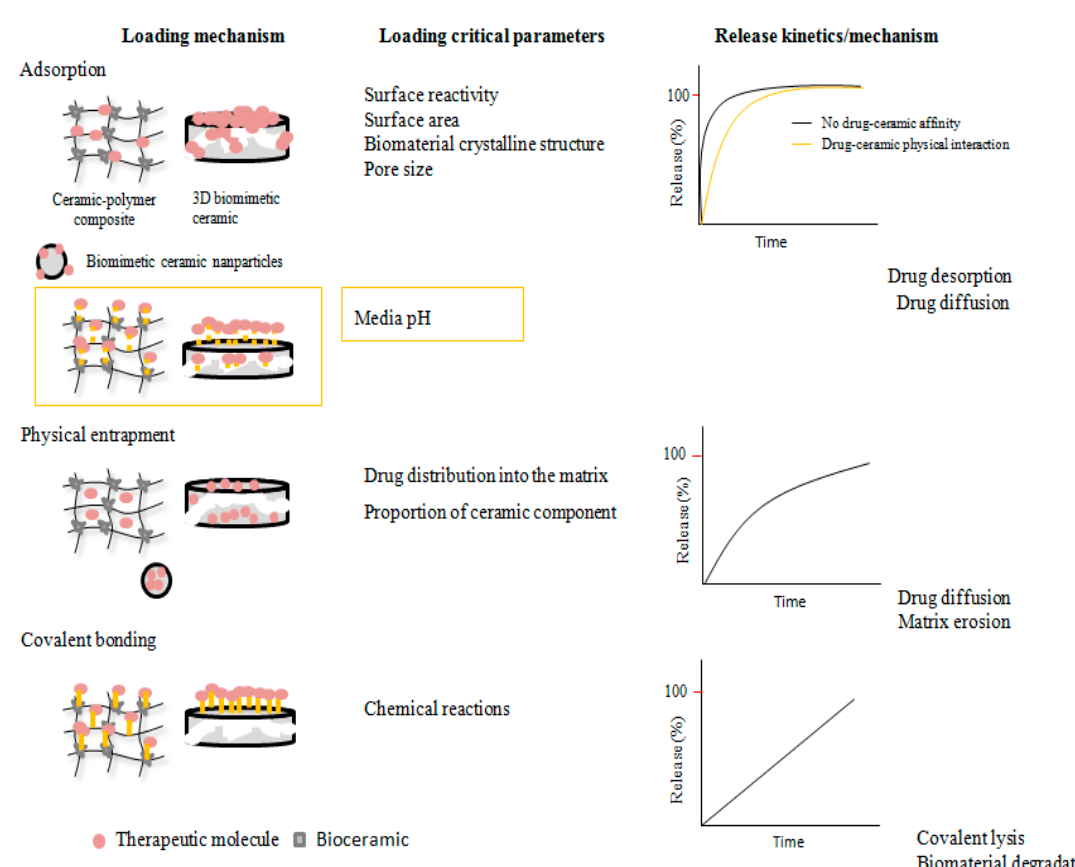
Figure 5. Summary of the main drug loading approaches used to incorporate therapeutic molecules on biomimetic ceramic systems.